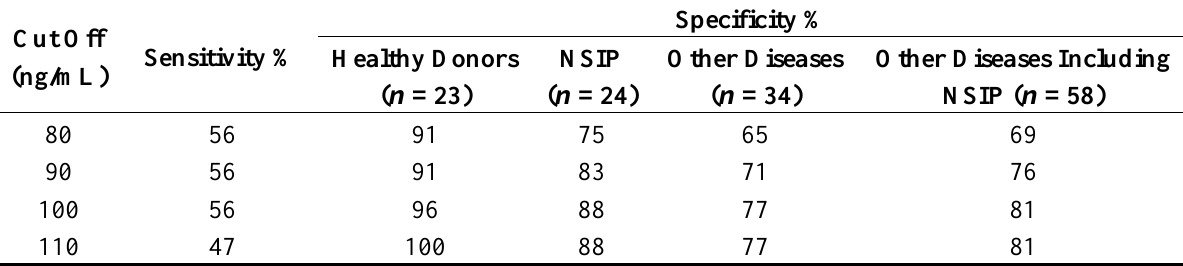
Table 3. Sensitivity and specificity values of free circulating DNA in discriminating between IPF patients (32) and healthy donors, or individuals with other non-malignant lung